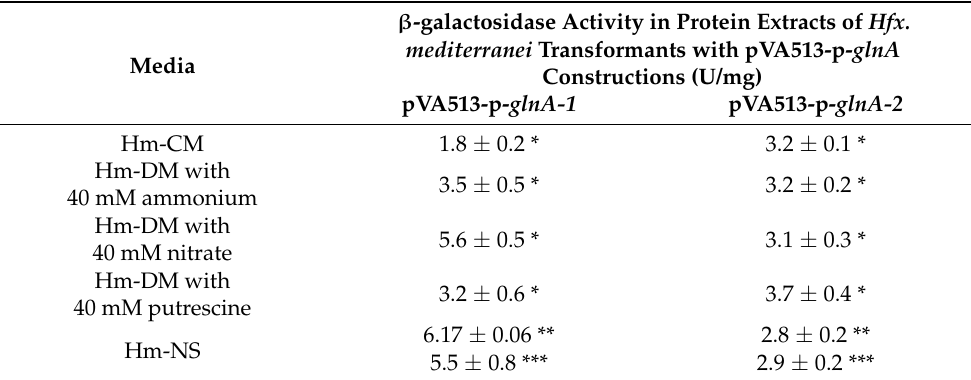
Table 3. Maximum β -galactosidase activity values obtained from cultures of the Hfx. mediterranei transformants with pVA513 constructions in the presence of different nitrogen sources. β -galactosidase Activity in Protein Extracts of Hfx. Media